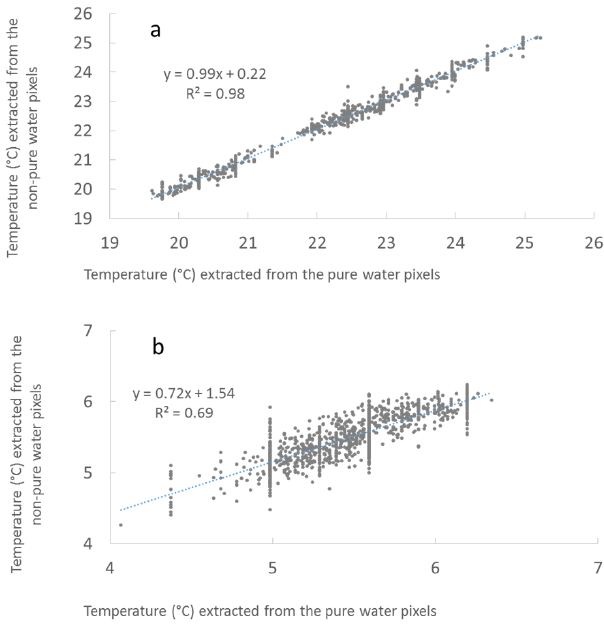
Figure 3. Relationship between the temperatures extracted from the non-pure water pixels and those from the pure water pixels. Temper- ature values of both pixel types were averaged over the successive 200m sections where pure water pixels existed. (a) Summer tem- peratures are represented. (b) Winter temperatures are represented.